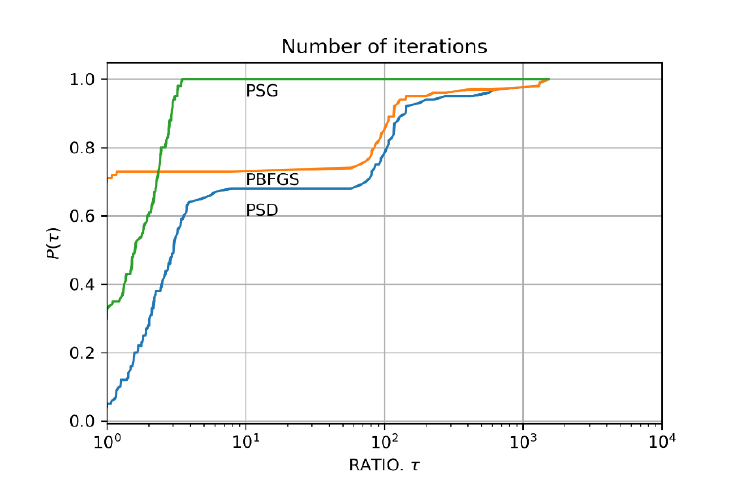
Fig. 1. Comparison of methods in terms of number of iterations.